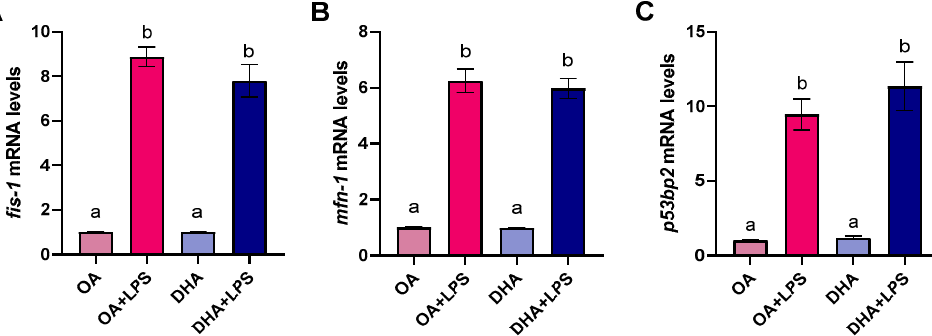
Figure 9. Transcript levels of mitochondrial fission protein 1 ( fis-1 ) ( A ) mitofusin 1 ( mfn-1 ) ( B ), and tumor protein P53 binding protein 2 ( p53bp2 ) ( C ) in mature adipocytes incubated for 6 days with 100 µ M oleic acid (OA) or 100 µ M docosahexaenoic acid (DHA) and thereafter exposed to lipopolysaccharide (LPS) for 20 h (OA + LPS and DHA + LPS, respectively). Samples ( n = 8 for OA and DHA groups and n = 6 for OA + LPS and DHA + LPS) were analyzed with real-time qPCR. Data are presented as fold change ± SEM using ef1 α as a reference gene and the OA group was set to one (delta-delta method). Different letters indicate significant differences between treatments ( p < 0.05, ANOVA followed by Tukey’s post hoc test).